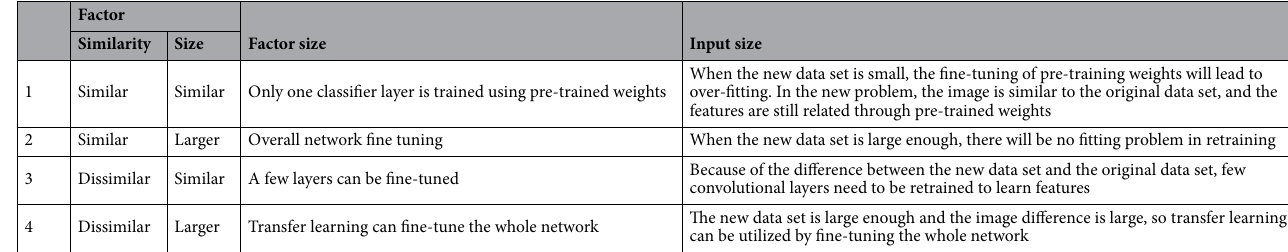
Table 1. Comparative analysis of image type correlation and size correlation of data set in transfer learning